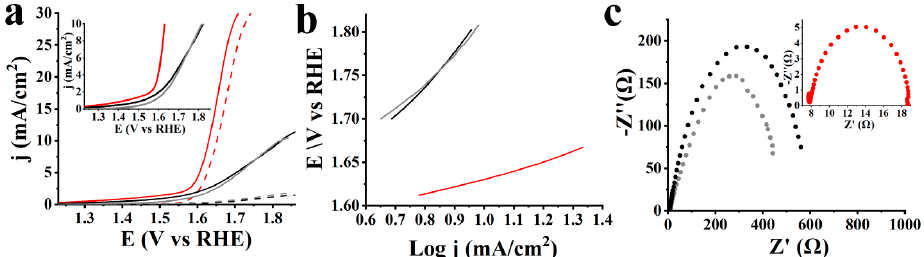
Figure 3. ( a , b ) HR-TEM micrographs showing the structure of S-CNHs. ( c ) XPS survey spectrum recorded on one of these S-CNHs samples, where S 2p , C 1s and O 1s are observed. Impurities <1% due to F are shown with *. ( d ) High-resolution S 2p XPS of S-CNHs. The peaks are fitted to four components centered at 162.2, 164.1, 165.3 and 168.4, corresponding to S p3/2 , S p3/2 , S p1/2 , and S-O, respectively.